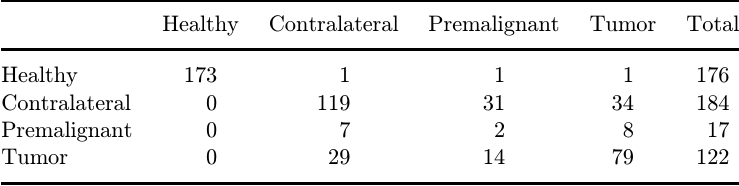
Table 8. PC-LDA for e±ciency of RS in identifying healthy, contralateral, premalignant and tumor conditions at tongue subsite.